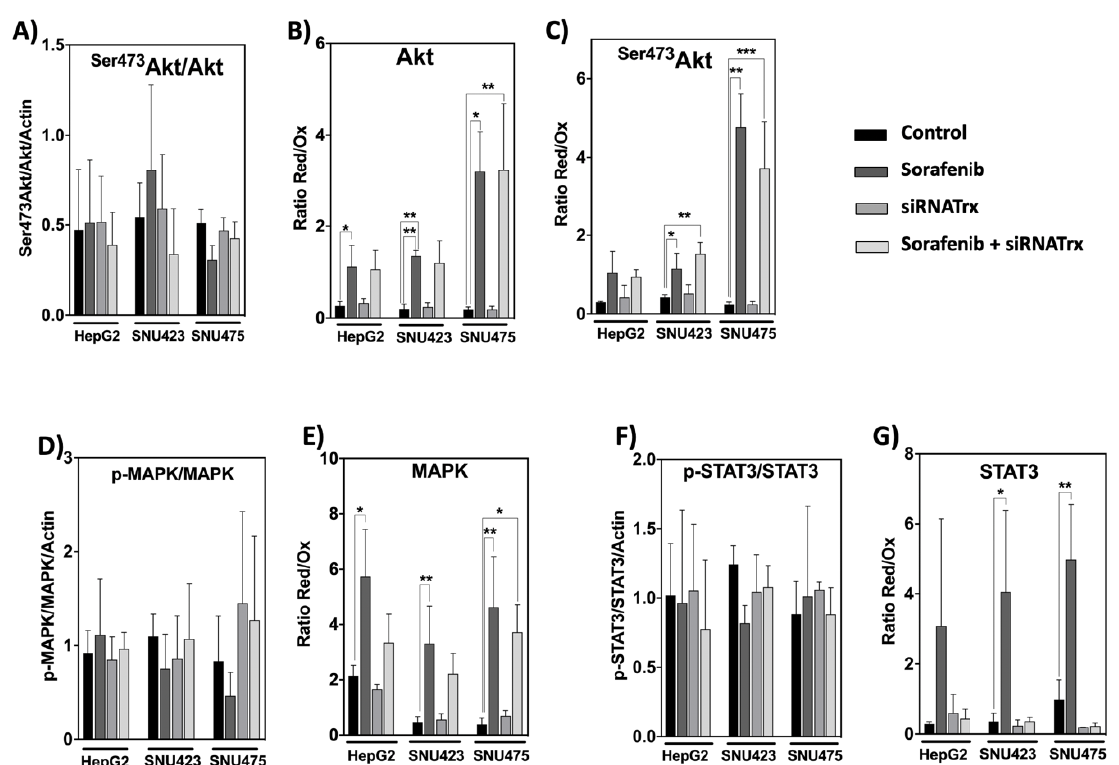
Figure 9. Phosphorylation and thiol redox state of key signaling elements in HCC cell lines treated with Sorafenib and / or siRNATrx1. The phosphorylated / unphosphorylated ratios of the indicated proteins were calculated from the densitometric quantitation data of each form normalized for ß-actin. The ratio Red / Ox reflects the thiol redox state and was calculated from the densitometric data of the bands obtained by the “thiol redox electrophoretic mobility shift assay” as described in Materials and Methods; samples from three di ff erent experiments ( N = 3) for each cell line were run in the same gel; protein levels cannot be compared between cells. p values 0.0332 (*), 0.0021 (**), 0.0002 (***), see Materials & Methods for statistical details. ( A ) Ratio of Ser473 pAkt / Akt; ( B , C ) thiol redox changes of Ser473 pAkt and Akt; ( D , E ) phosphorylation and redox changes, respectively, of MAPK; the same is shown for STAT3 in ( F , G ).